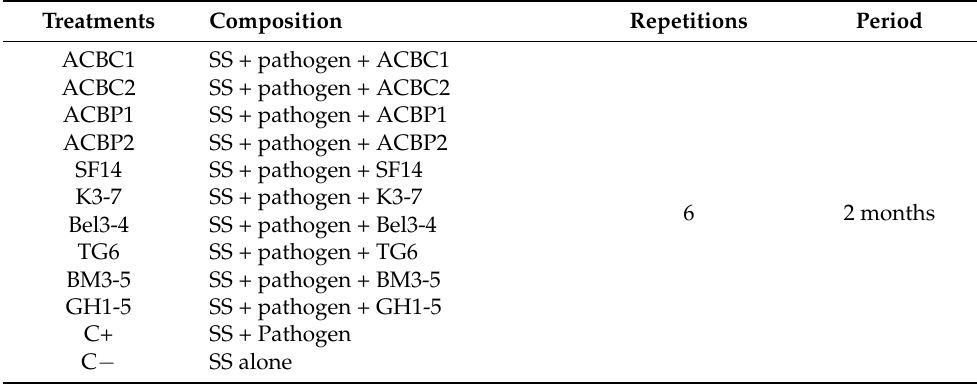
Table 1. Treatments used in the in vivo bioassays. Treatments Composition Repetitions Period ACBC1 SS + pathogen + ACBC1